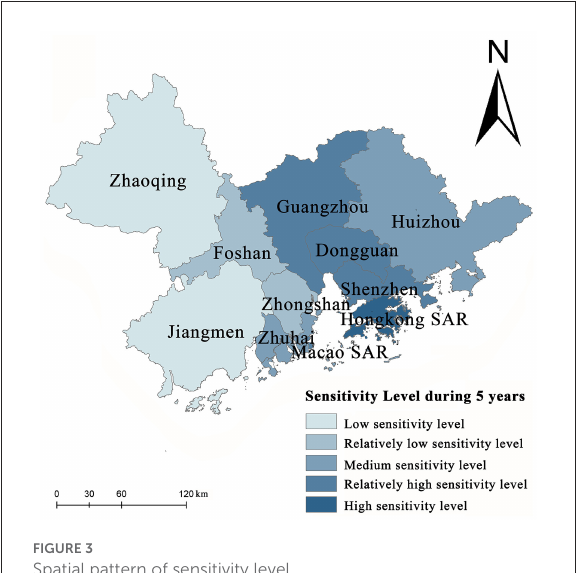
FIGURE3 Spatial pattern of sensitivity